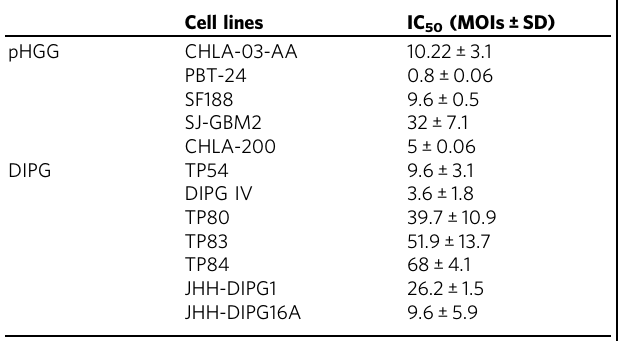
Table 1 Median-effect doses (IC 50 ) of Delta-24-RGD in pHGG and DIPG cell